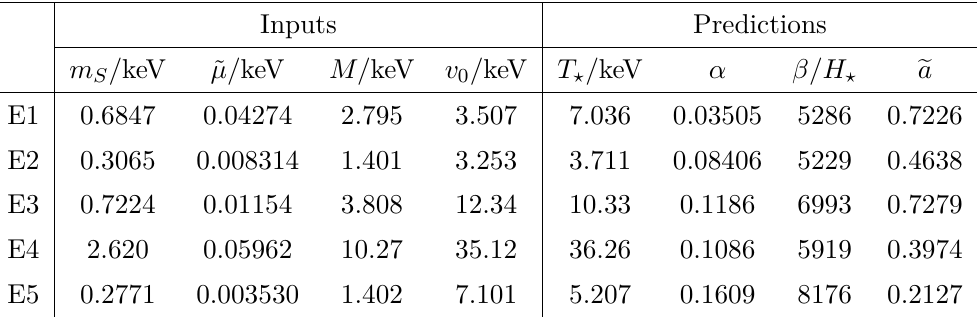
Table 5 . Values of the parameters corresponding to the five benchmark (starred) points in figure